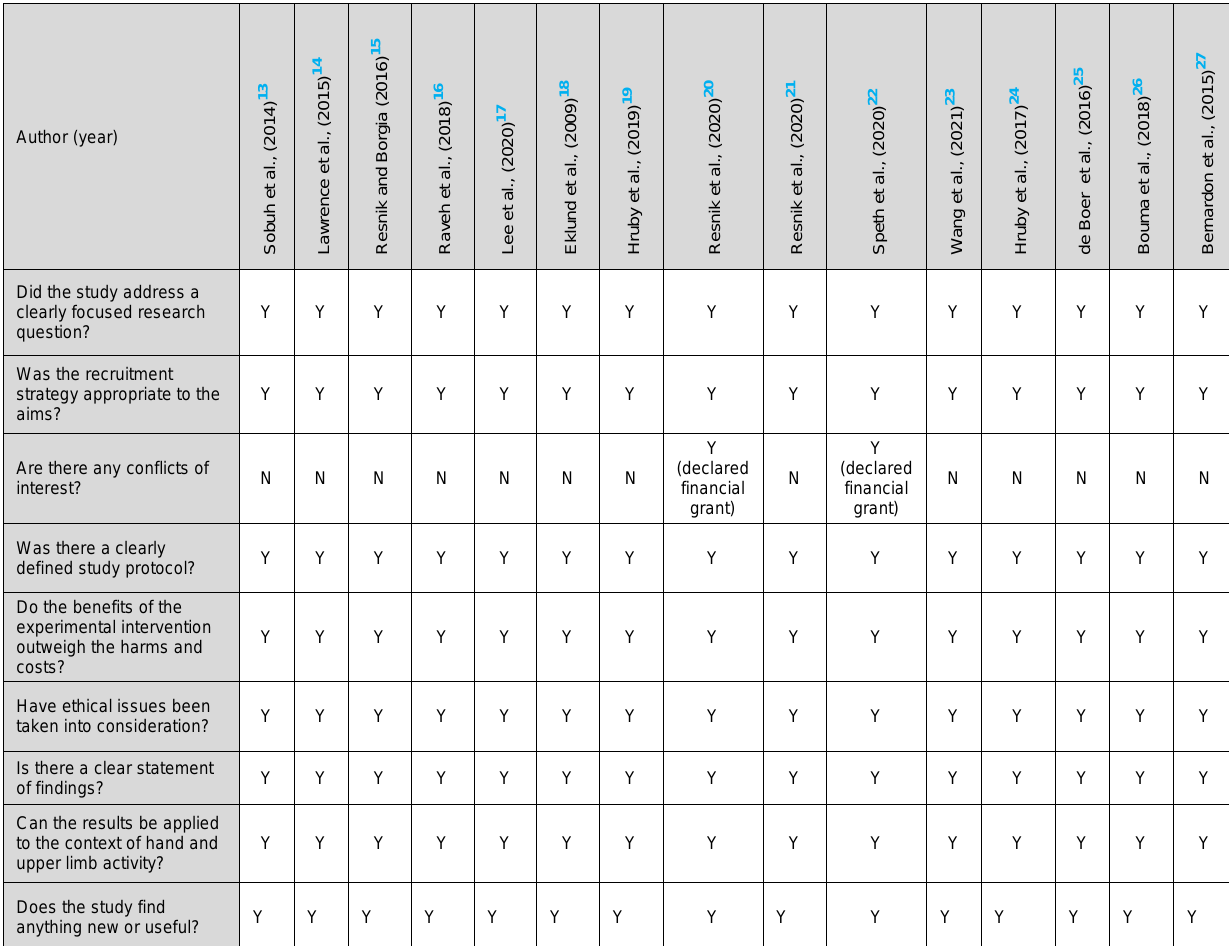
Table 1: Quality appraisal